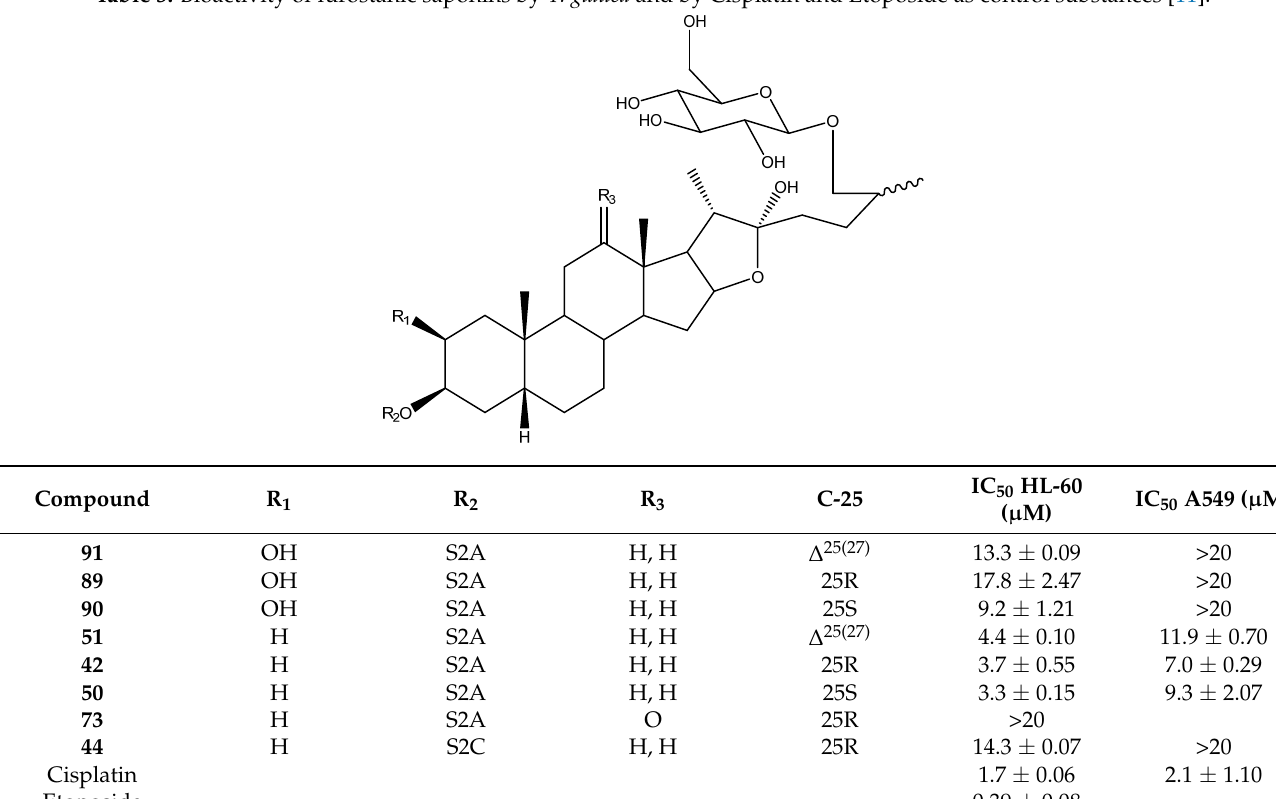
Table 3. Bioactivity of furostanic saponins by Y. glauca and by Cisplatin and Etoposide as control substances [11].